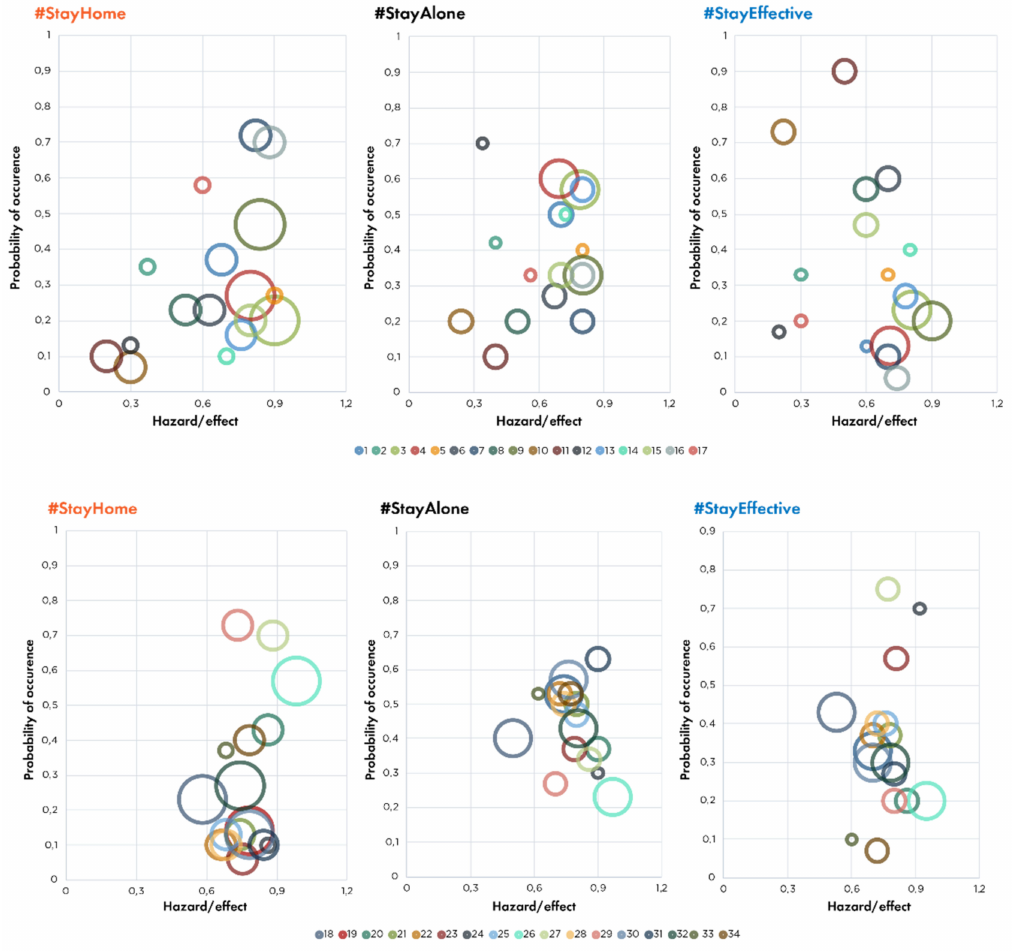
Figure 5. Risk assessment for three scenarios: #StayHome, #StayAlone,